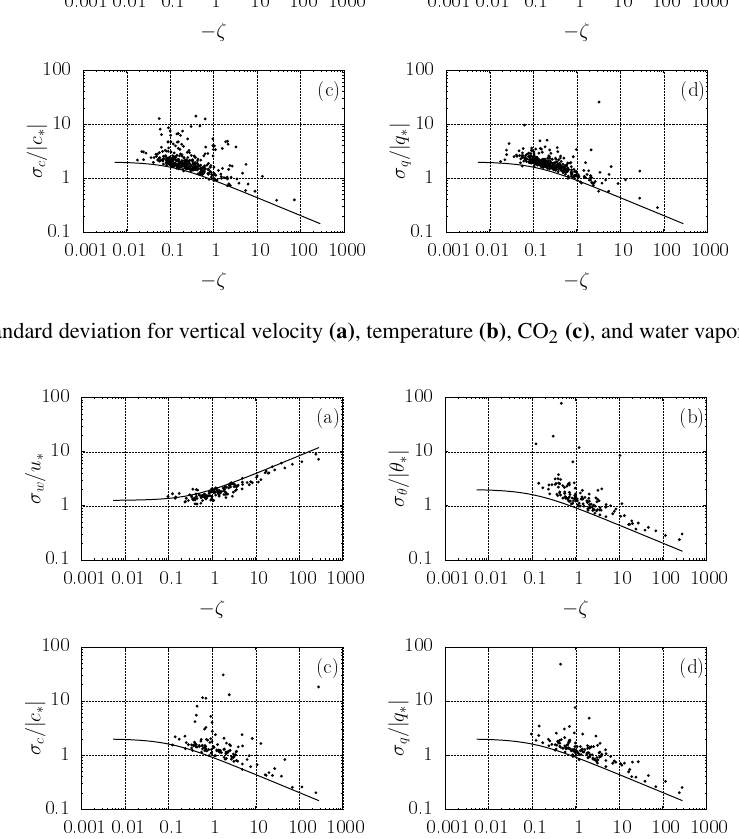
Note that this RSL “excess variance” (in comparison with MOST predictions) does not impact the fluxes (Katul et